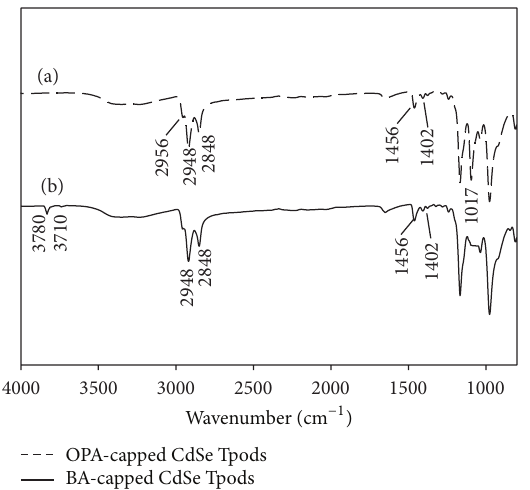
Figure 3: The X-ray diffraction patterns of CdSe tetrapods with the reference peak positions of bulk Wurtzite CdSe (ICDD-JCPDS: CdSe # 00-019-0191)